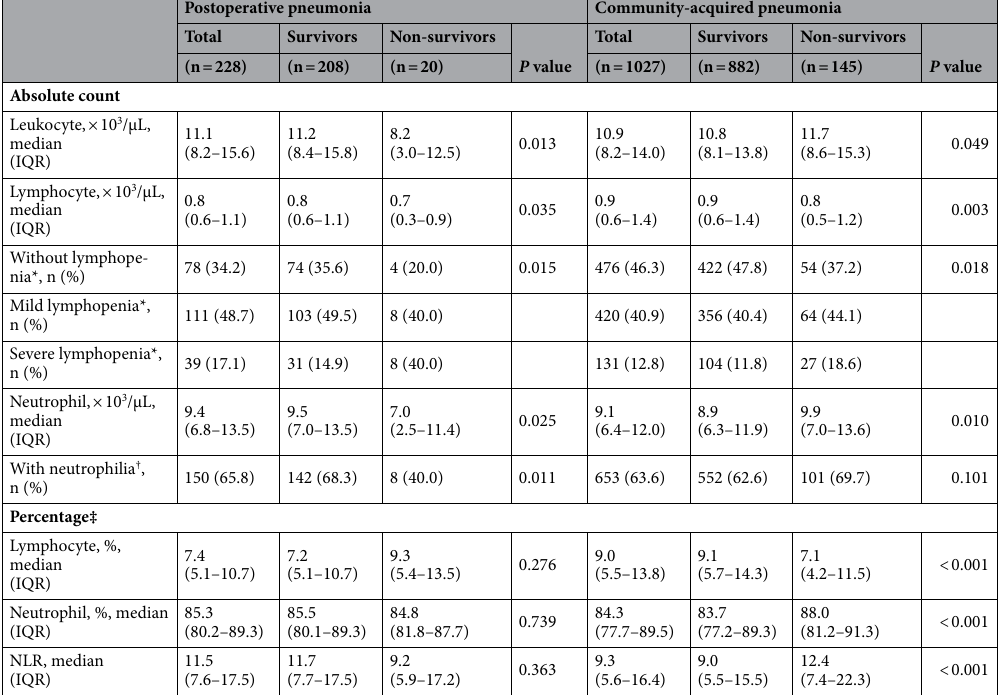
Table 2. Findings of blood leukocytes, lymphocytes, and neutrophils at pneumonia diagnosis. IQR Interquartile range, NLR Neutrophil to lymphocyte ratio. *Patients were classified according to absolute lymphocyte counts (ALCs) at pneumonia diagnosis, as follows: severe lymphopenia, ALC < 0.5 × 10 3 cells/ μL; mild lymphopenia, ALC of 0.5–0.9 × 10 3 cells/μL; and without lymphopenia, ALC ≥ 1.0 × 10 3 cells/μL. † According to absolute neutrophil counts (ANCs) at pneumonia diagnosis, patients with ANC > 7.5 × 10 3 cells/ μL were defined as those with neutrophilia and patients with ANC ≤ 7.5 × 10 3 cells/μL were defined as those without neutrophilia. ‡ Percentages indicate those among total